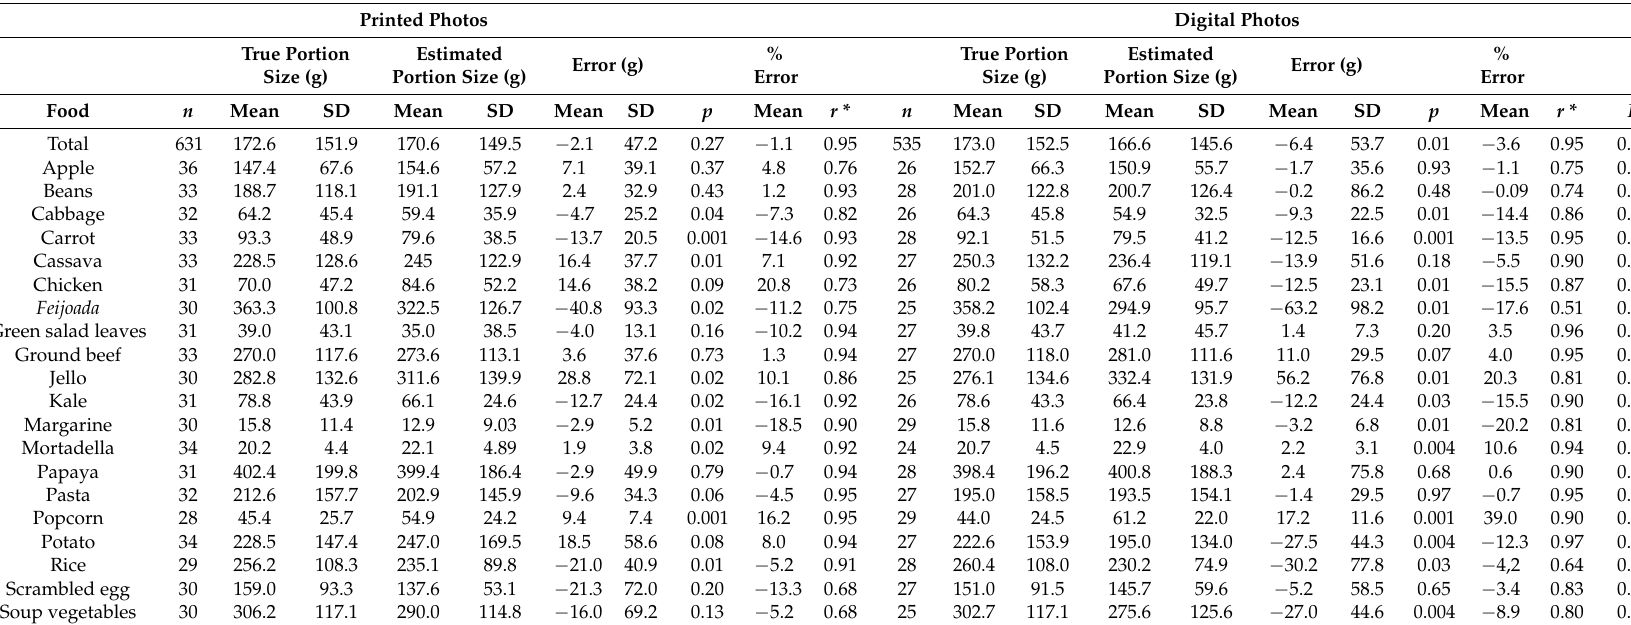
Table 1. Number of evaluations, mean and standard deviation of the true and the estimated portion sizes, error (g and %) and correlation between the true photo and the chosen